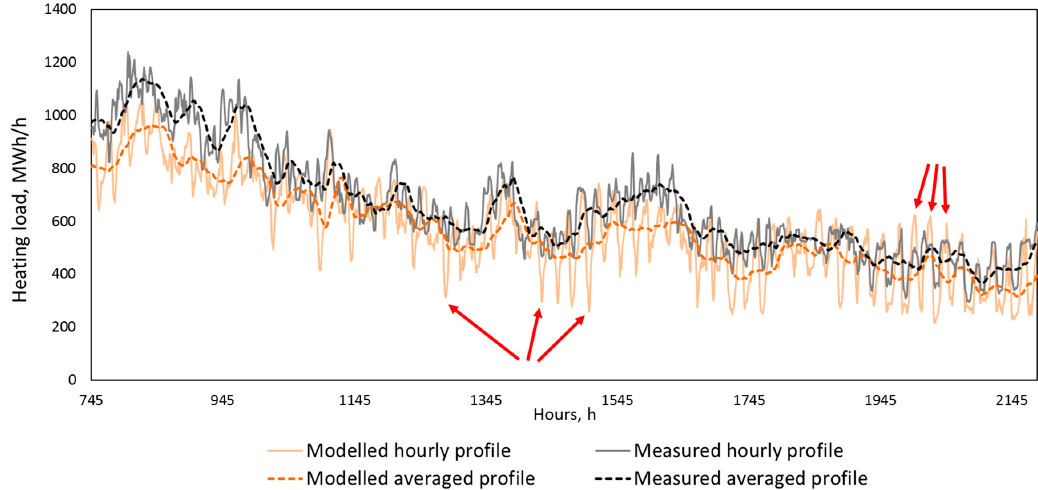
Figure 2. The measured and modeled heat generation profiles of the investigated DH system of the City of Gothenburg presented for February and March of 2012. The daily averaged profiles are obtained by applying the moving average function with the 24 h interval to the original hourly profiles. The red arrows mark pronounced variations in the modeled heat generation profiles.